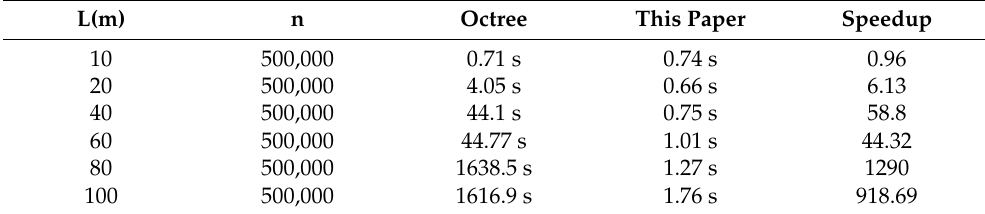
Table 2. Time-consuming comparison of voxel segmentation for regions of different sizes using two